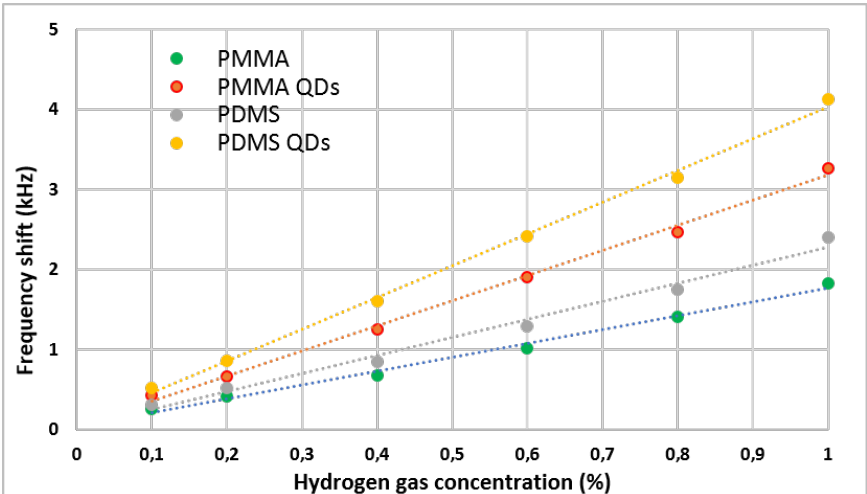
Figure 4. Frequency shift of the sensors for different concentrations of hydrogen. Sensors 2019 , 19 , x FOR PEER REVIEW